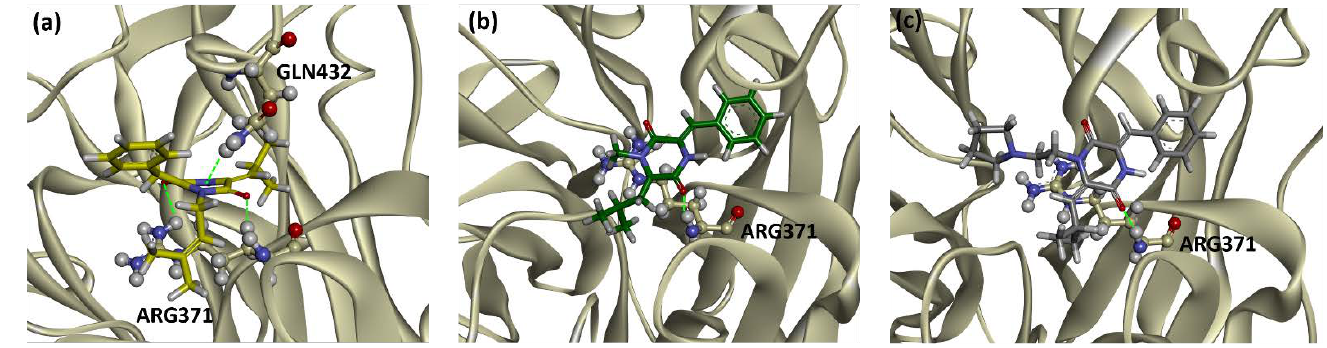
Figure 4. Hydrogen bond interactions of compound 13c ( a ) , 13d ( b ) , and 14c ( c ) in the cavity Avian influenza virus H5N2 ( PDB ID : 5HUK ).